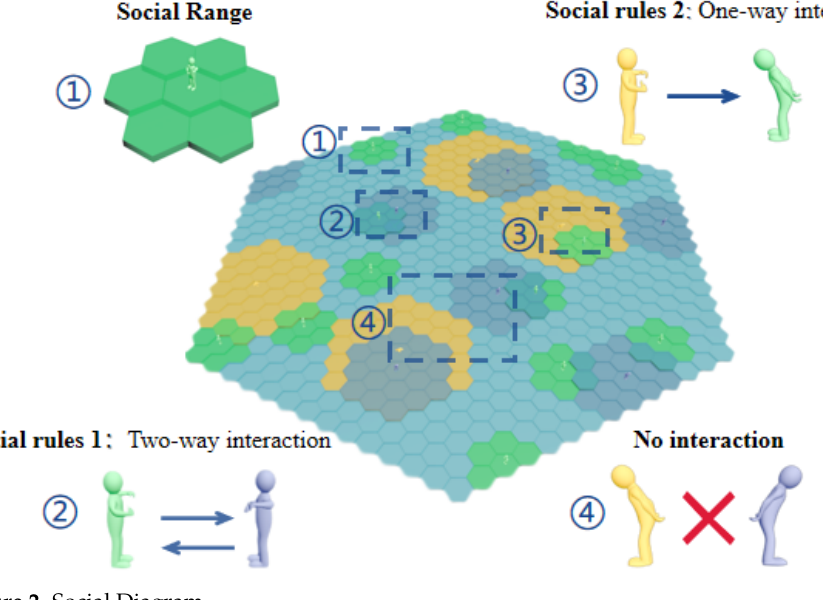
Figure 2. Social Figure 2. Social Diagram.